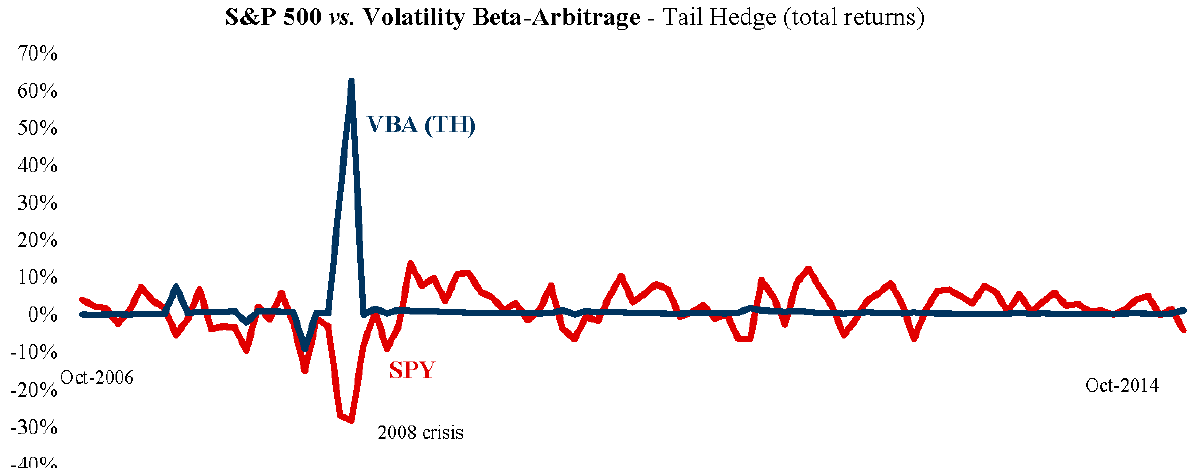
Figure A4. Another visualization of an even greater counter to the 2008